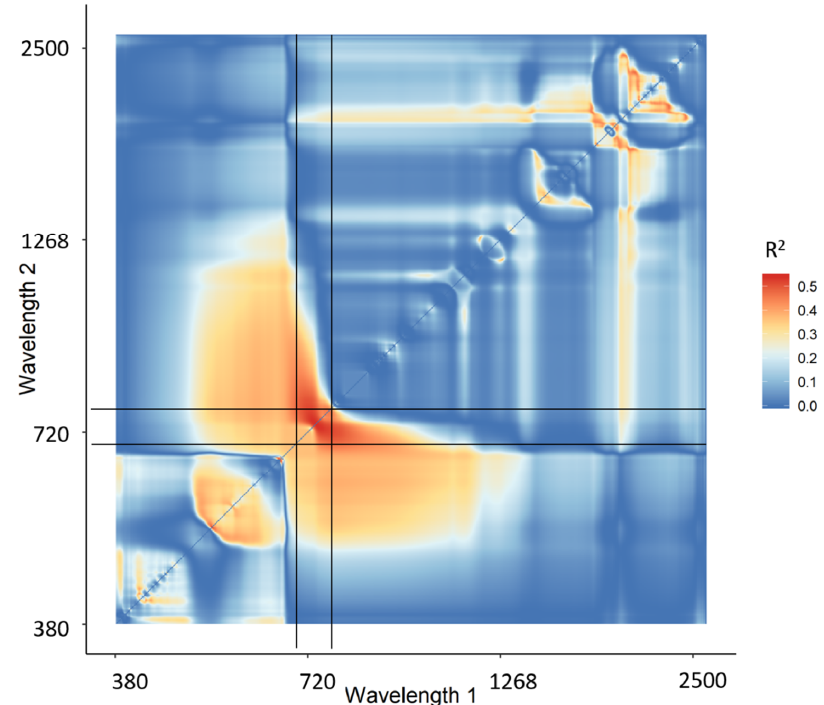
Figure 4. 2-D correlation plot of R 2 of canopy chlorophyll content and narrowband Datt derivative index (not cross-validated). The vertical and horizontal black lines indicate the red edge region between 680–780 nm.